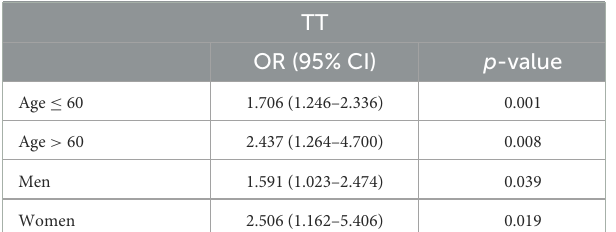
TABLE 8 Multiple logistic regression analysis for CI patients and control